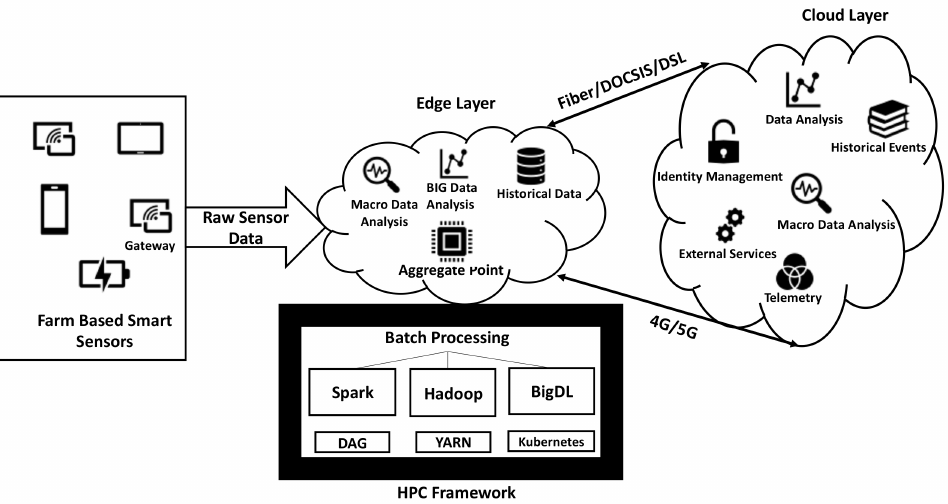
Figure 12. High Performance Computing on